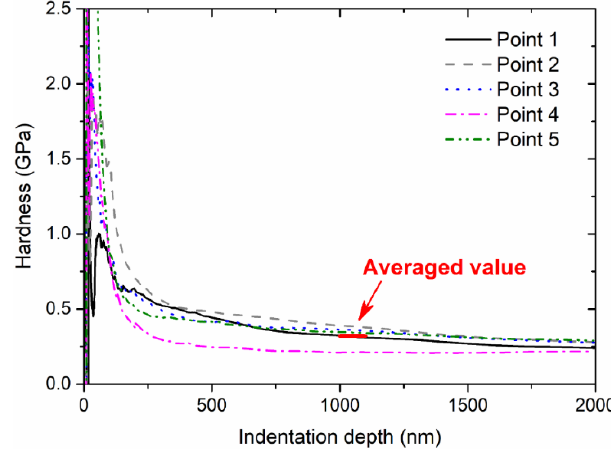
Figure 5. Measured value of hardness as a function of indentation depth.